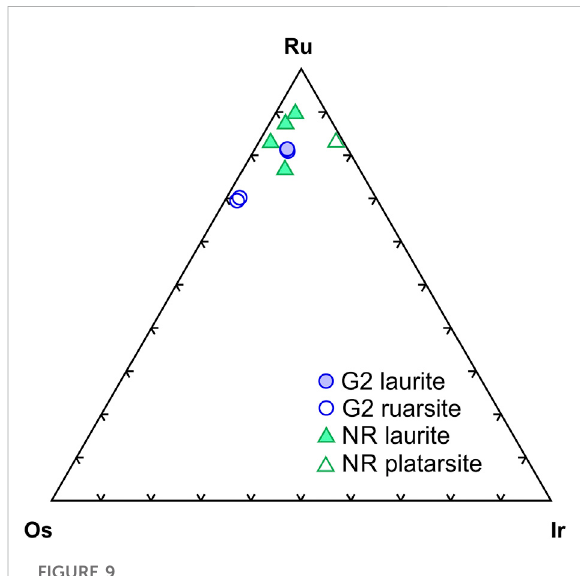
FIGURE 9 Ternary diagram of PGM analyses; open symbols represent secondary PGM, whereas full symbols represent primary PGM.